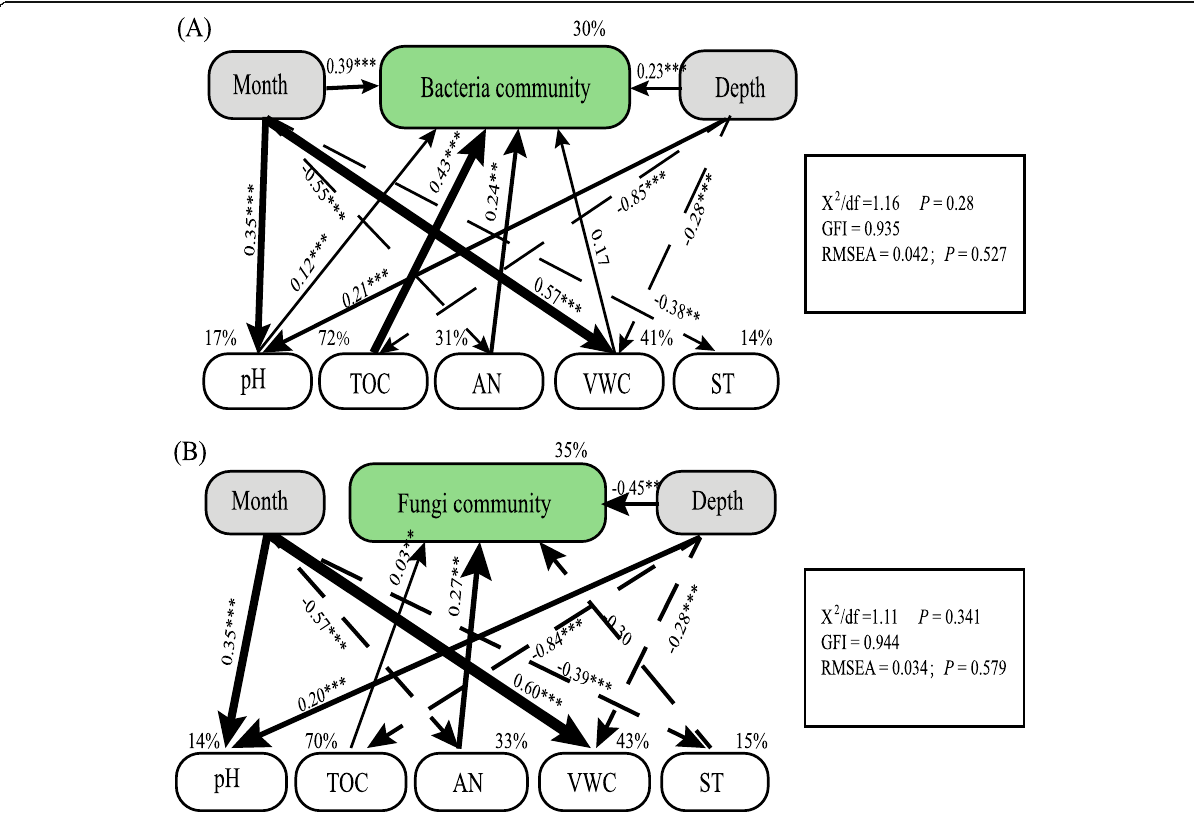
Fig. 4 SEM analysis of bacteria and fungus with environmental factors. a , b represent structural equation model analysis of bacteria and fungi. TOC, AN, VWC, ST represent as above; BC bacterial community, FC fungi community. Solid arrows indicate positive correlations, and dotted arrows indicate negative correlations. Values associated with arrows indicate standardized path coefficients (* p < 0.05; ** p < 0.01; *** p < 0.001). Arrow width represents the size of the corresponding normalized path coefficient. Percentage ( R 2 ) associated with response variables represent the proportion of contributed to variation by other